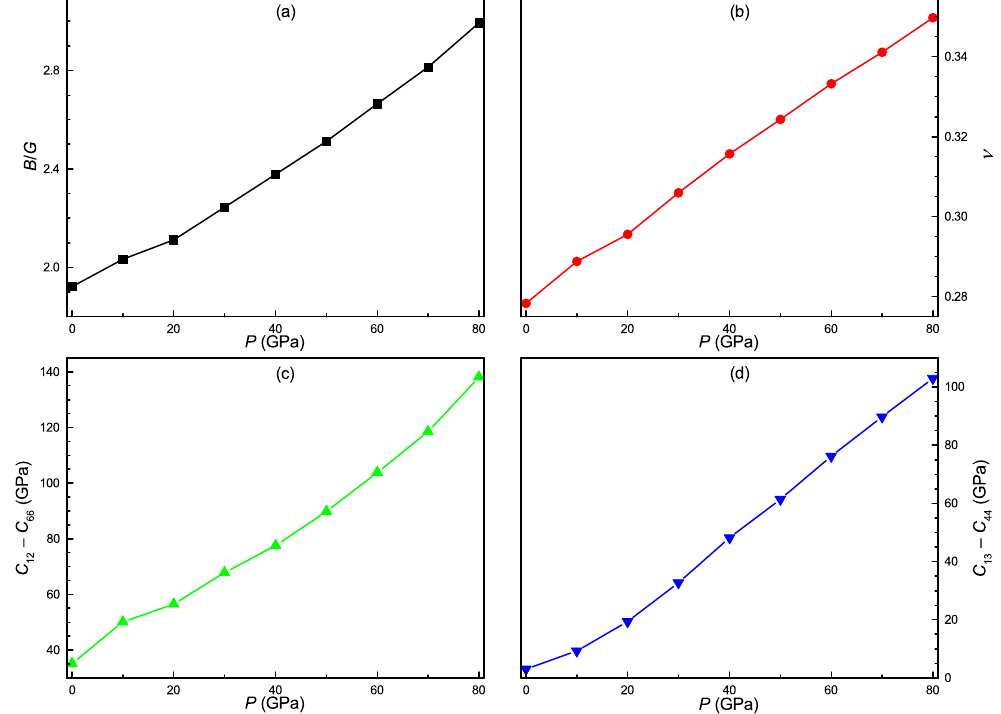
Figure 5. B / G ratio ( a ), Poisson’s ratio ( b ), and Cauchy pressures C 12 − C 66 ( c ), C 13 − C 44 ( d ) as a function of pressure for Ti 3